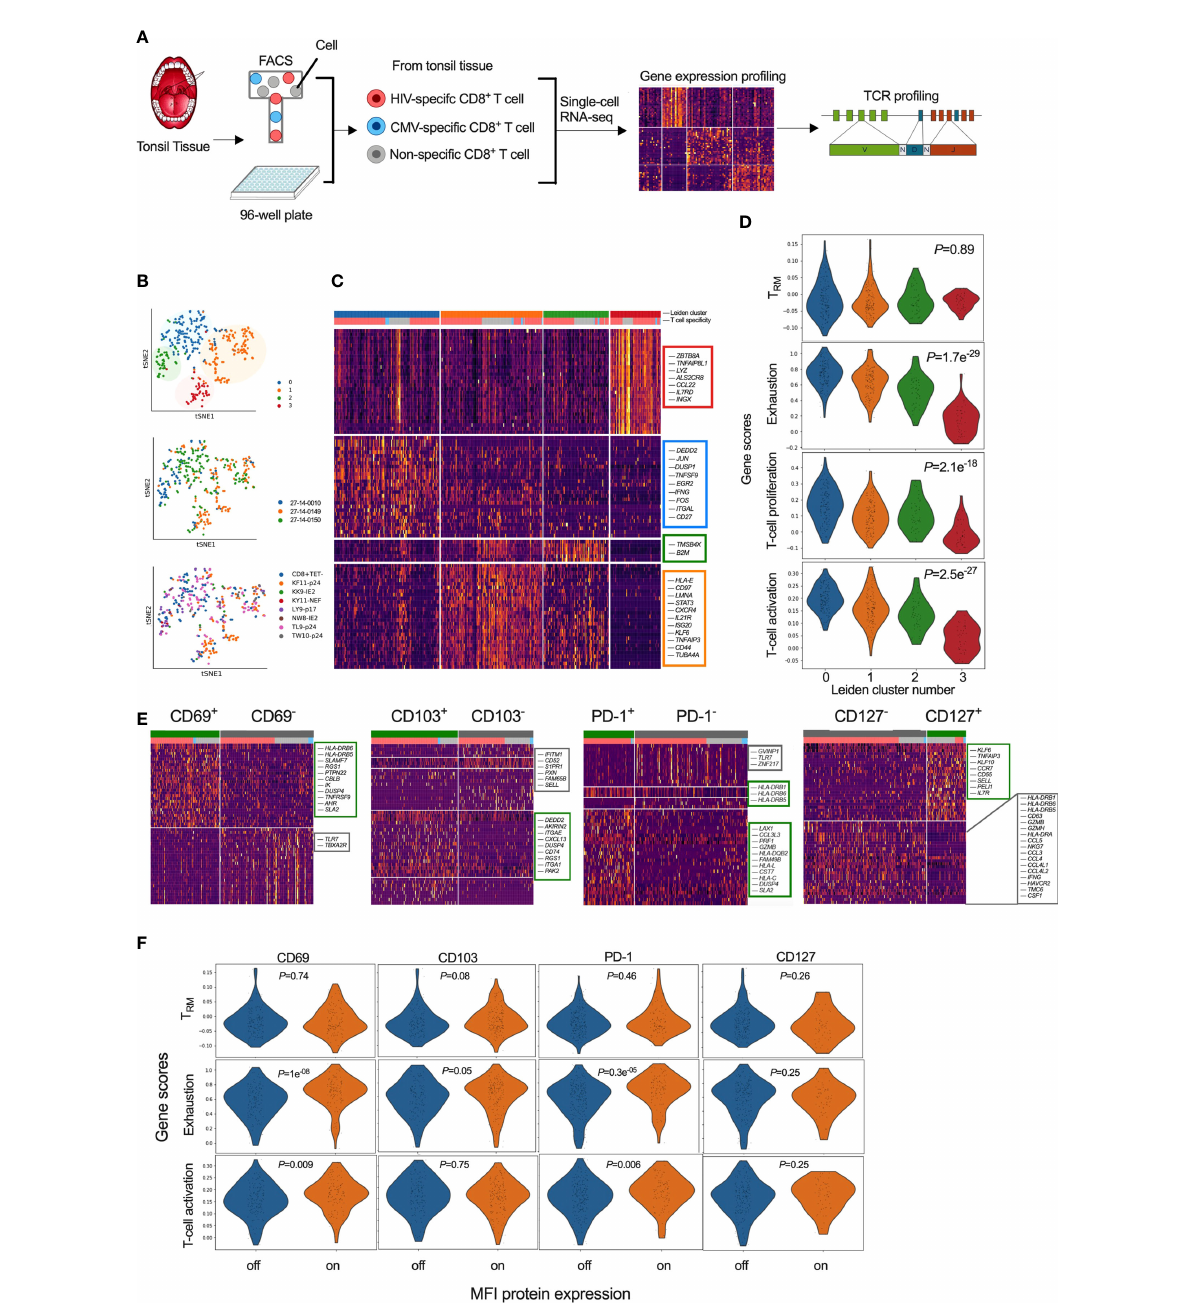
FIGURE 5 Single-cell transcriptional pro fi ling of CD8 + T-cells within HIV infected tonsils reveals heterogenous and distinct subsets grouped by T-cell exhaustion gene set enrichment scores. (A) Work fl ow of scRNAseq from HIV infected tonsil isolated CD8 + T-cells pre-sorted on HIV-, CMV- and ‘ non-speci fi c ’ CD8 + T-cells from HIV infected participants ( n= 3) (see Supplemental Table S2). (B) Dimensionality reduction using tSNE on scRNAseq cells coloured by Louvain cluster (top), participant ID (middle), and tetramer speci fi city (bottom). (C) Heatmap of z-scored gene expression of top differentially expressed genes (t-test) between Louvain clusters from scRNAseq data with cells grouped by Louvain cluster, genes grouped by hierarchical clustering (full gene lists in Supplemental Table S3). (D) Gene set enrichment scores for each of the 4 Louvain clusters (0-3) shown for ‘ T RM ’ (39), ‘ Exhaustion ’ (70), ‘ proliferation ’ and ‘ activation ’ published gene lists (71, 72). (E) Heatmaps of z-scored gene expression of top differentially expressed genes (t-test) between single cells with high and low normalized MFI values of CD69, CD103, PD-1 and CD127. Selected genes labelled in plot, full gene lists in Supplemental Tables S4, S5. (F) Gene lists from (E) scored against the published gene lists as indicated in